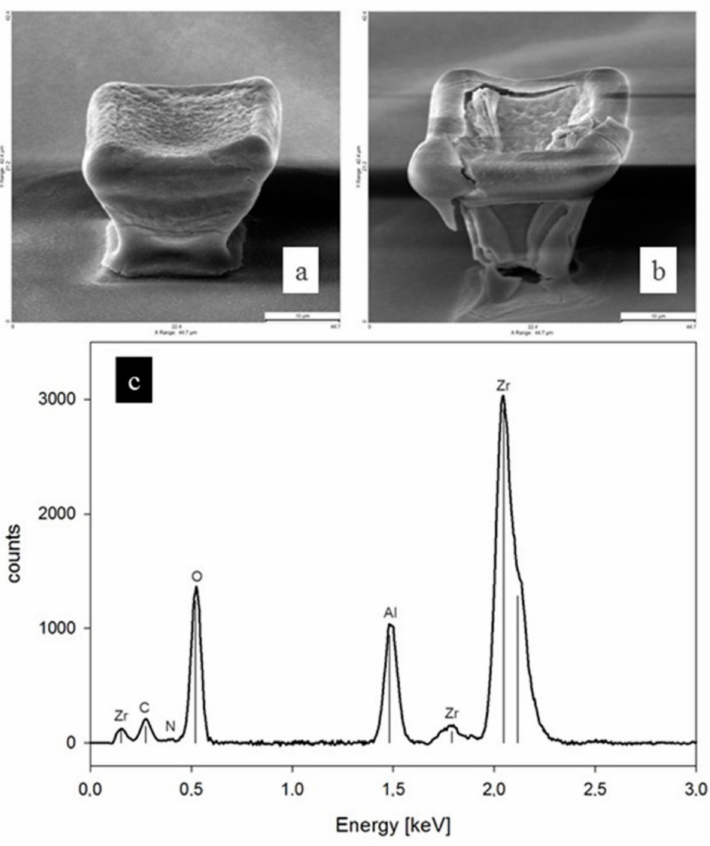
Figure 6. TPA fabricated 3D structure from an ATZ slurry before ( a ) and after ( b ) a non-optimized de-bonding process (scale bar: 10 µ m). Elemental composition (EDX analysis ( c )) after de-bonding shows the main elements of this ATZ